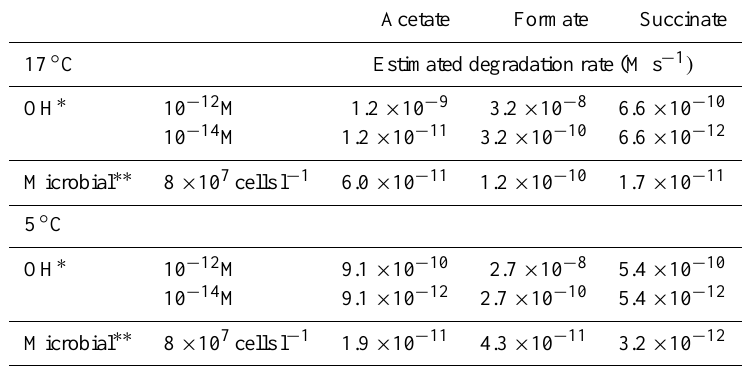
Table 5. Experimental biodegradation rates in artificial cloud water at 17 ◦ C and 5 ◦ C and calculated photodegradation rates by OH of acetate, formate and succinate.